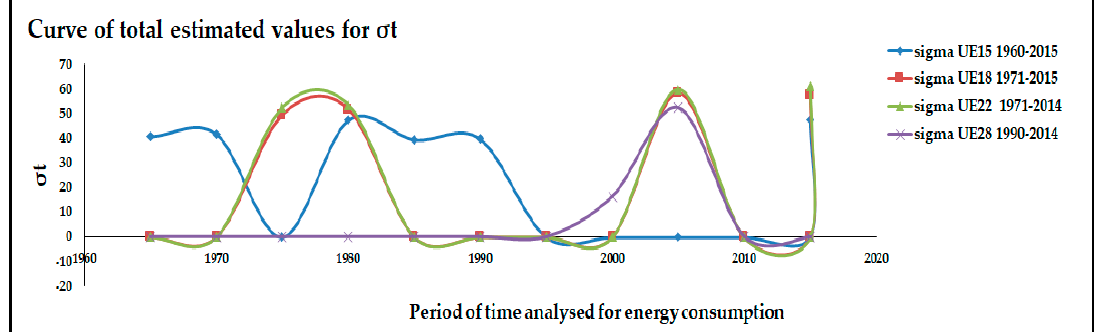
Figure 6. Graphical representation of total values obtained for σ t energy consumption.